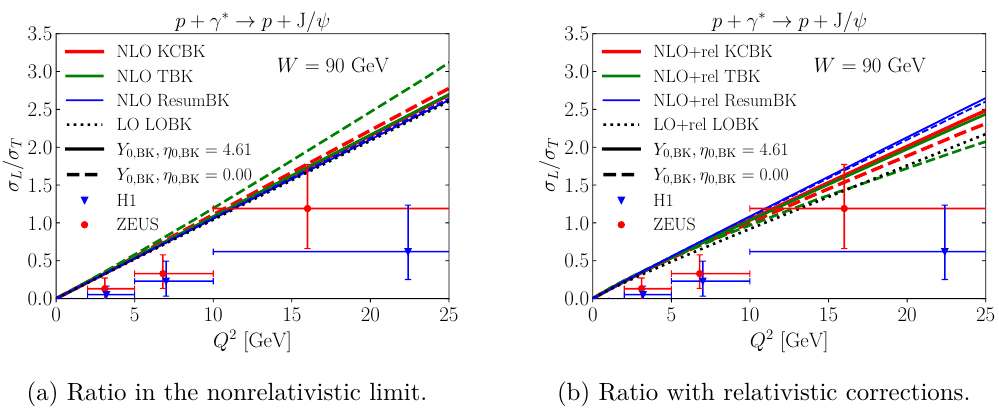
Figure 5. Longitudinal J /ψ production cross section divided by the transverse cross section compared to H1 [9] and ZEUS [7] data at W = 90 GeV.